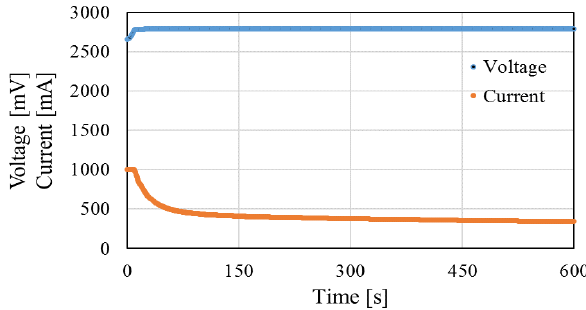
Figure 8. Charging characteristic of Ni-MH 2 cell in series during CCCV mode.